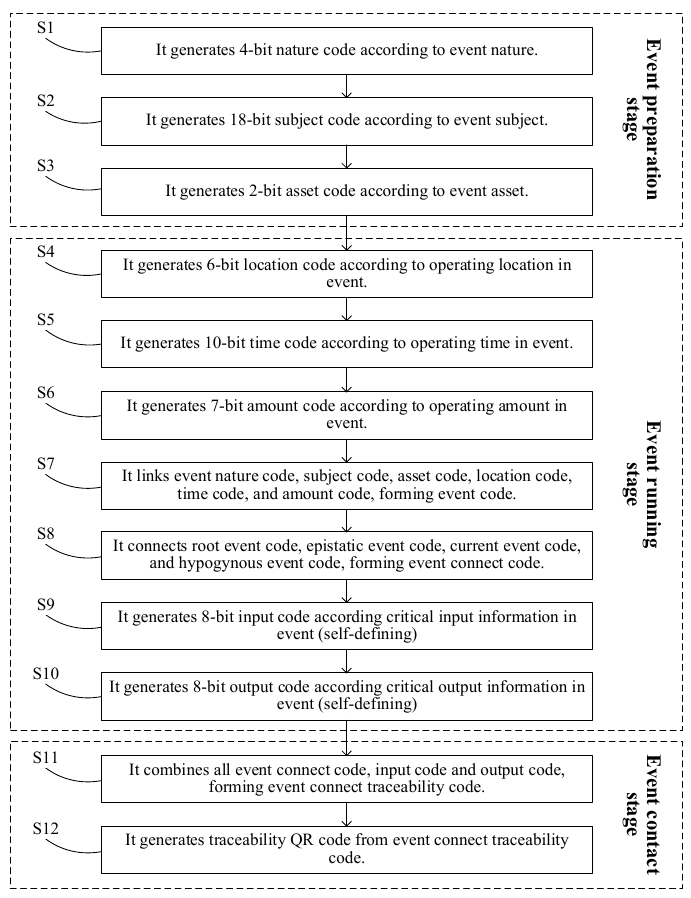
Figure 10. One event contact traceable coding method. Table 1. 5T Post-harvest management technique code for high-quality paddy (Jilin